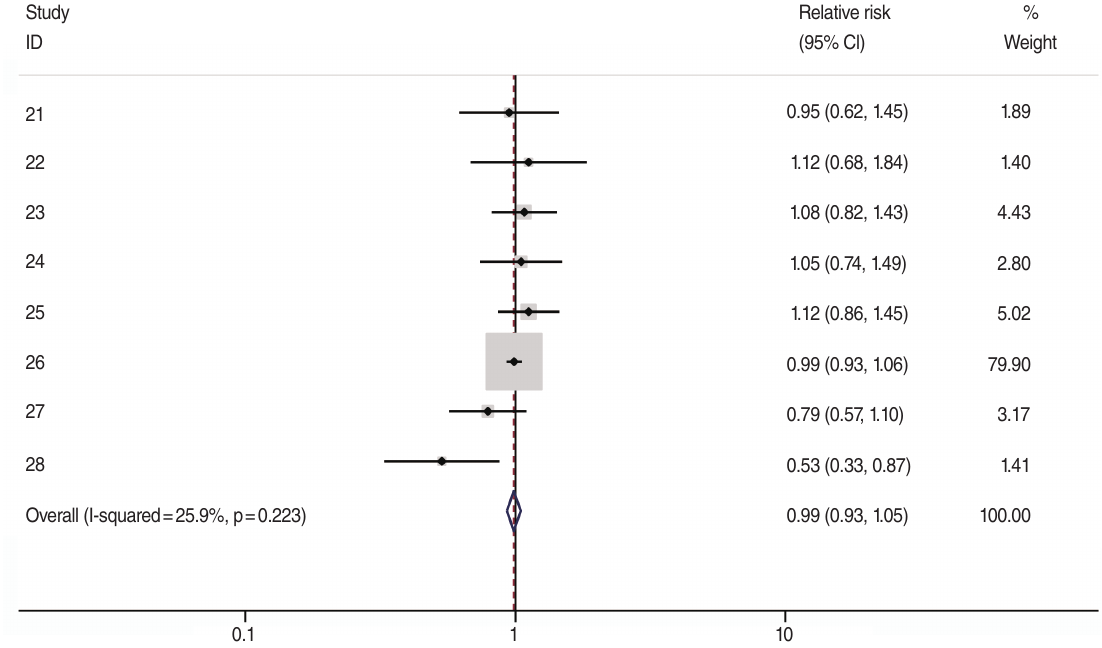
Figure 3. A forest plot using fixed-effects summary estimates in 8 cohort articles evaluating the association between intake of citrus fruits and pancreatic cancer risk. ID, reference number; CI, confidence interval.